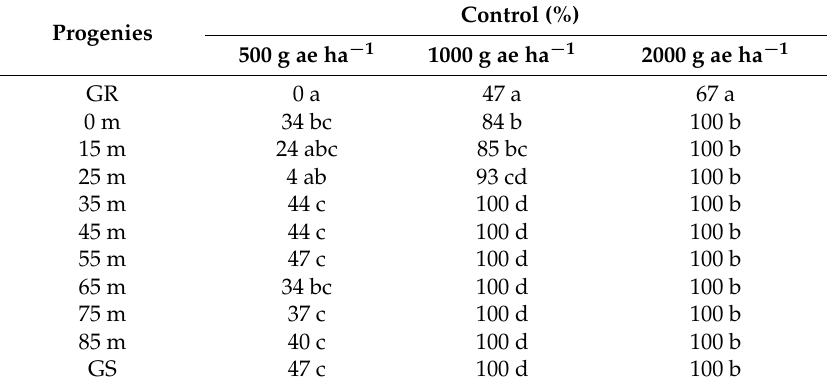
Table 2. Mean percentage of control of the progeny of pollen receptor plants (spaced from 0 to 85 m from the glyphosate-resistant plants as the source of pollen), glyphosate-resistant plants (GR, positive control) and isolated glyphosate-susceptible plants (GS, negative control) sprayed with glyphosate at 500, 1000, and 2000 g ae ha − 1 . Means followed by the same letter within columns are not significantly different at p = 0.05 (Tukey’s HSD